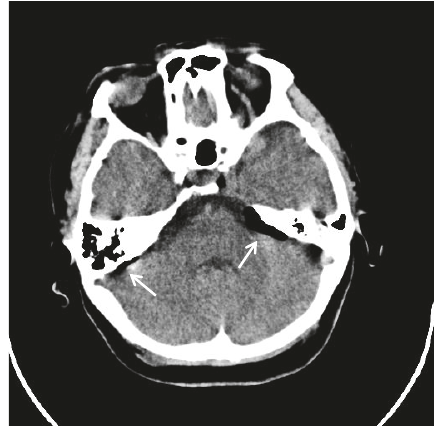
Figure 3: Axial CT brain demonstrating pneumocephalus in the posterior cranial fossa (arrowhead).